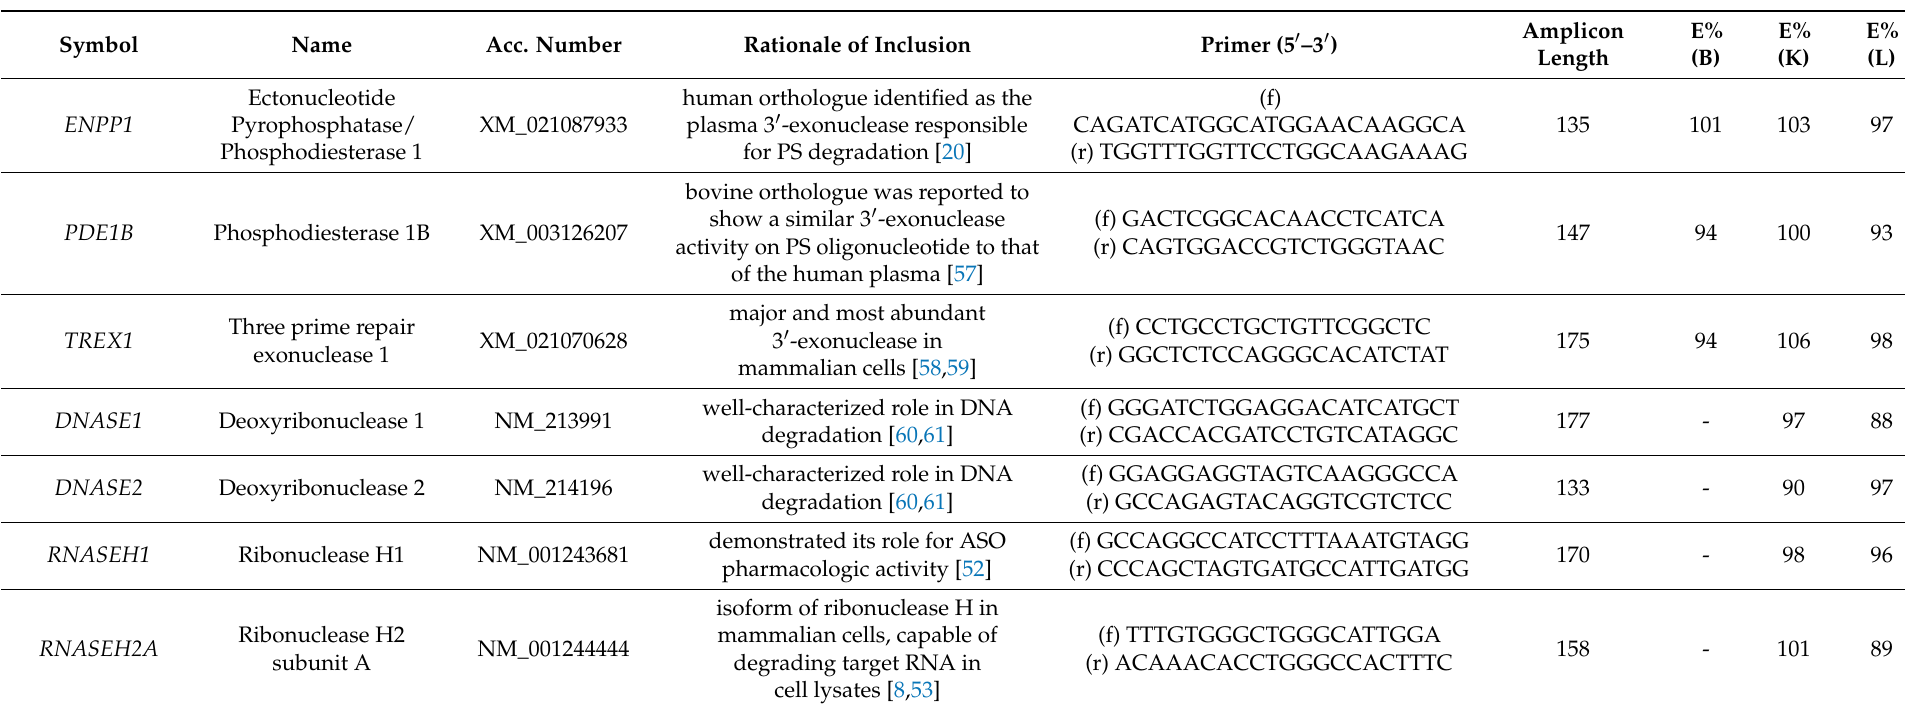
Table 1. Primer design for qPCR, gene details, and PCR efficiencies in the three analyzed tissues: blood (B), kidney (K), and liver